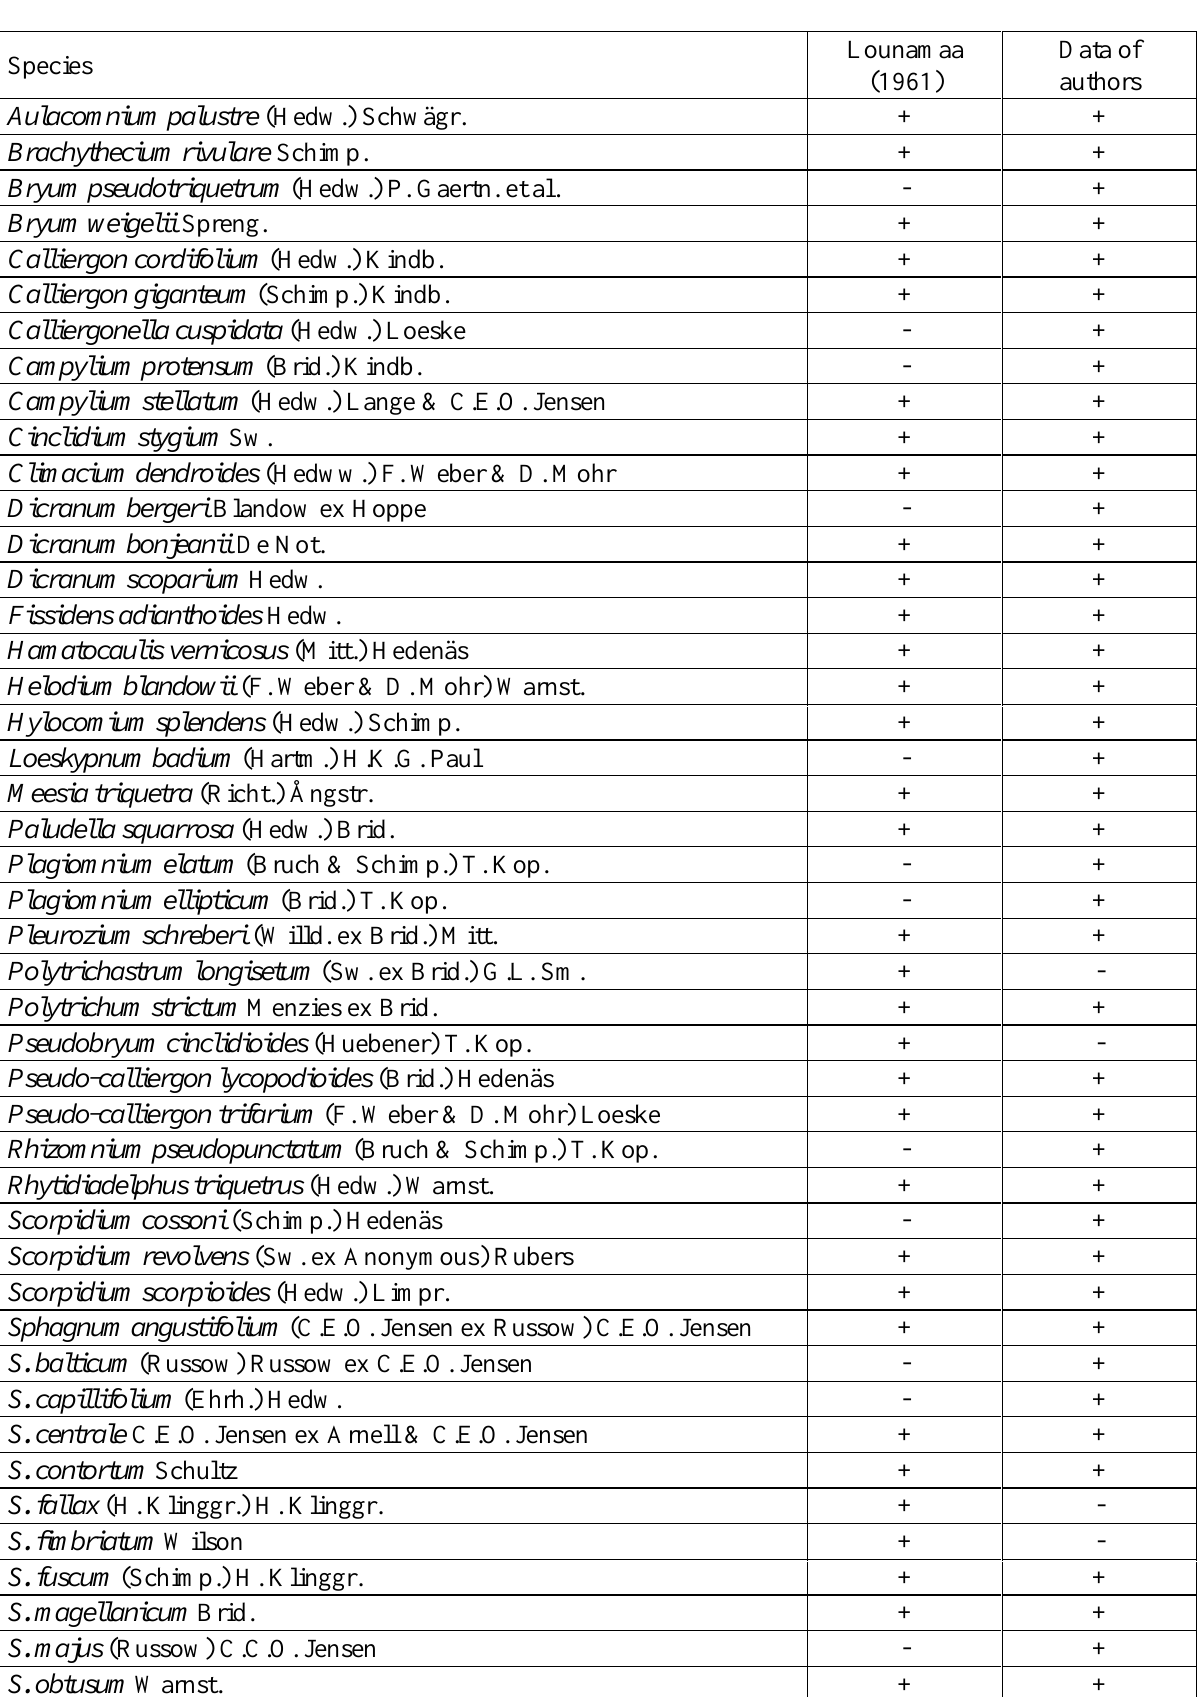
Table A2. List of mosses on mires around Kolatselka. The nomenclature follows Ulvinen et al .